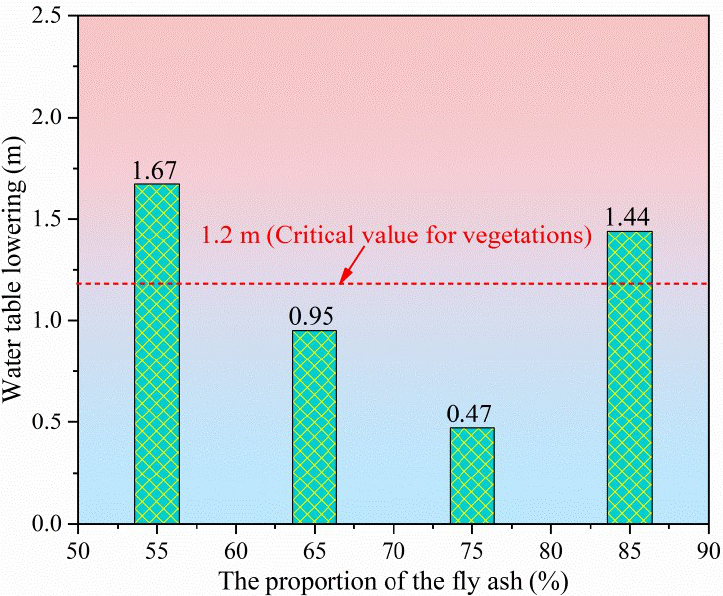
Figure 16. Fluid–mechanism coupling simulation of shallow water level lowering while injecting CMFB with different proportions of fly ash. Table 6. The statistical results of the relationship between the growth of surface vegetation and the groundwater level